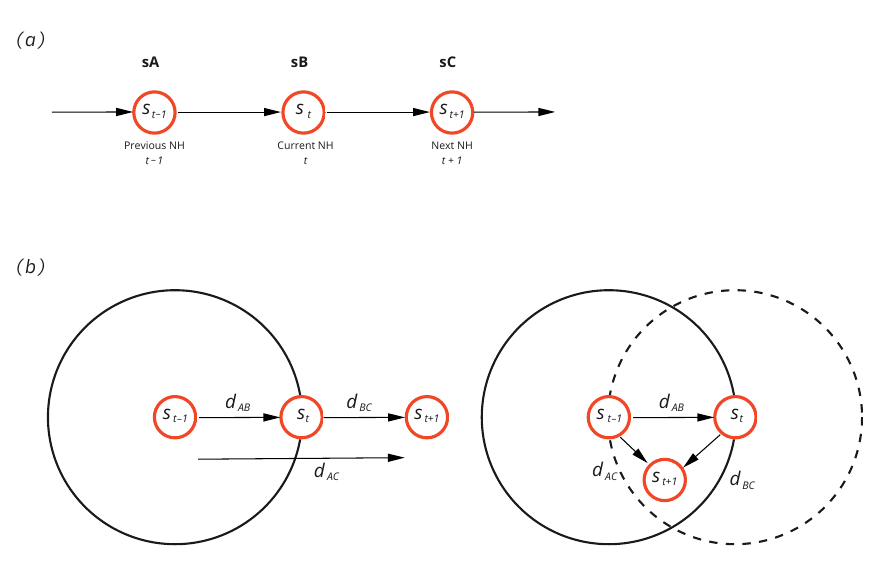
Figure 4. ( a ) NH sequence in time series, where s t − 1 , s t , and s t + 1 , represent the previous, current, and future position (antennas) of a device m , centered in time t . ( b ) The model needs to consider different spatial behaviors, where s t + 1 could be closer to s t − 1 than s t